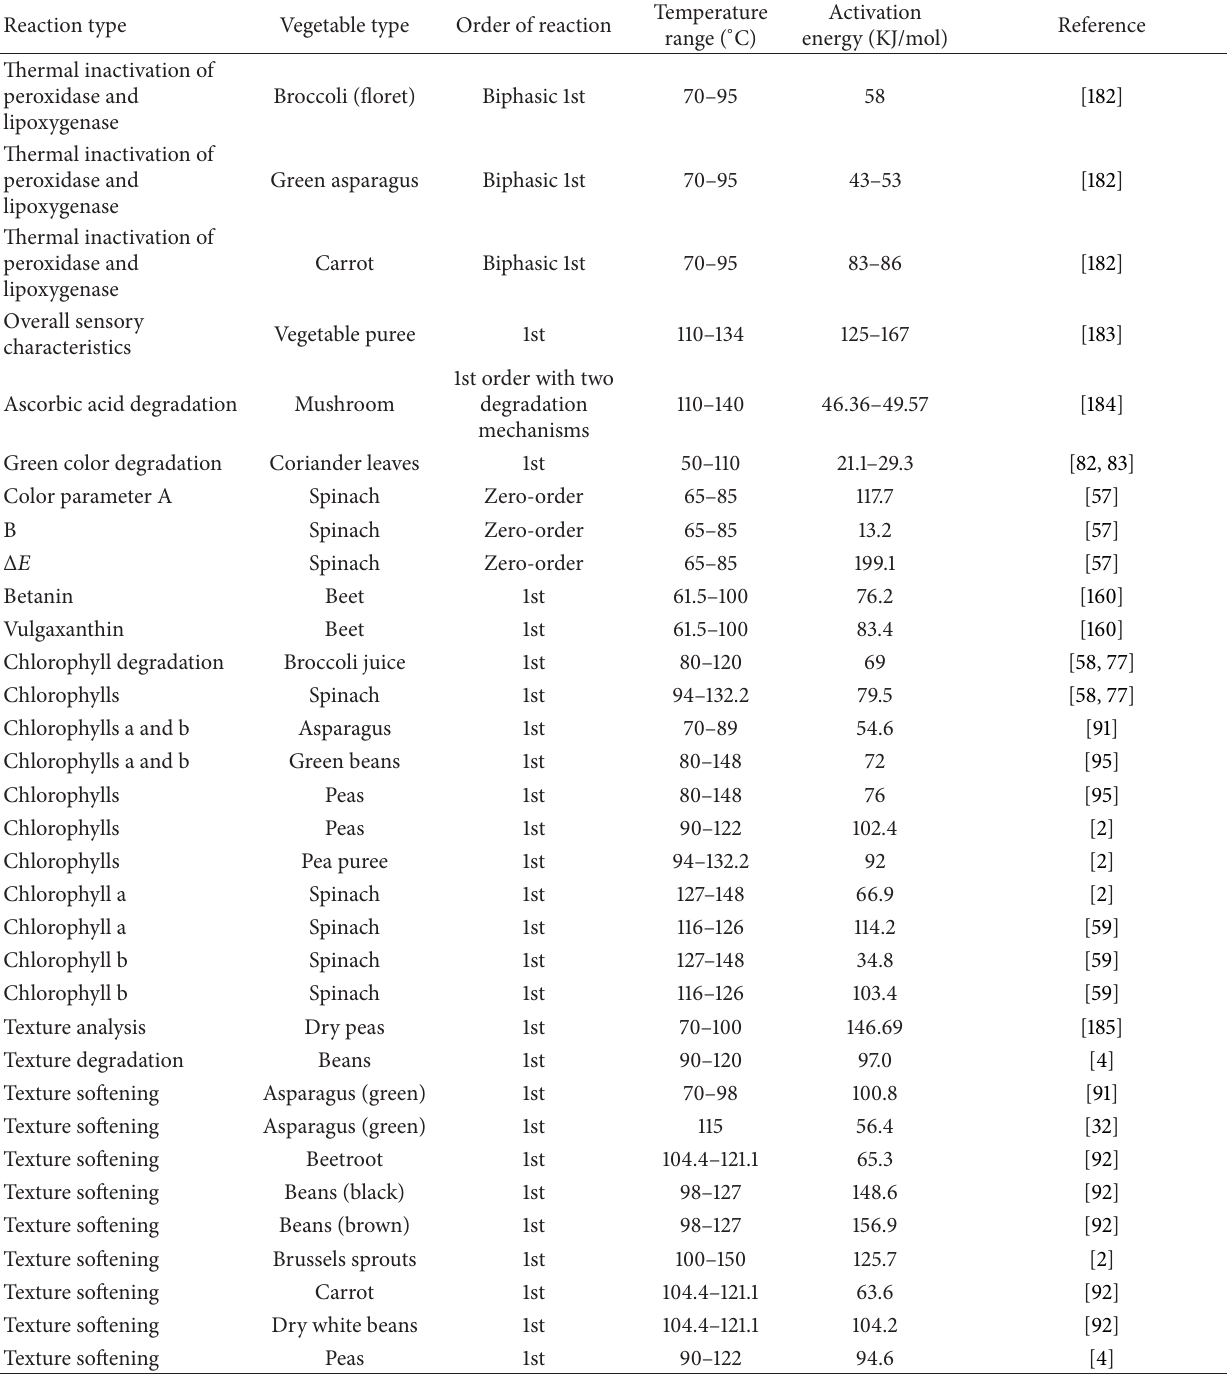
Table 2: Kinetic parameters associated with quality attributes of